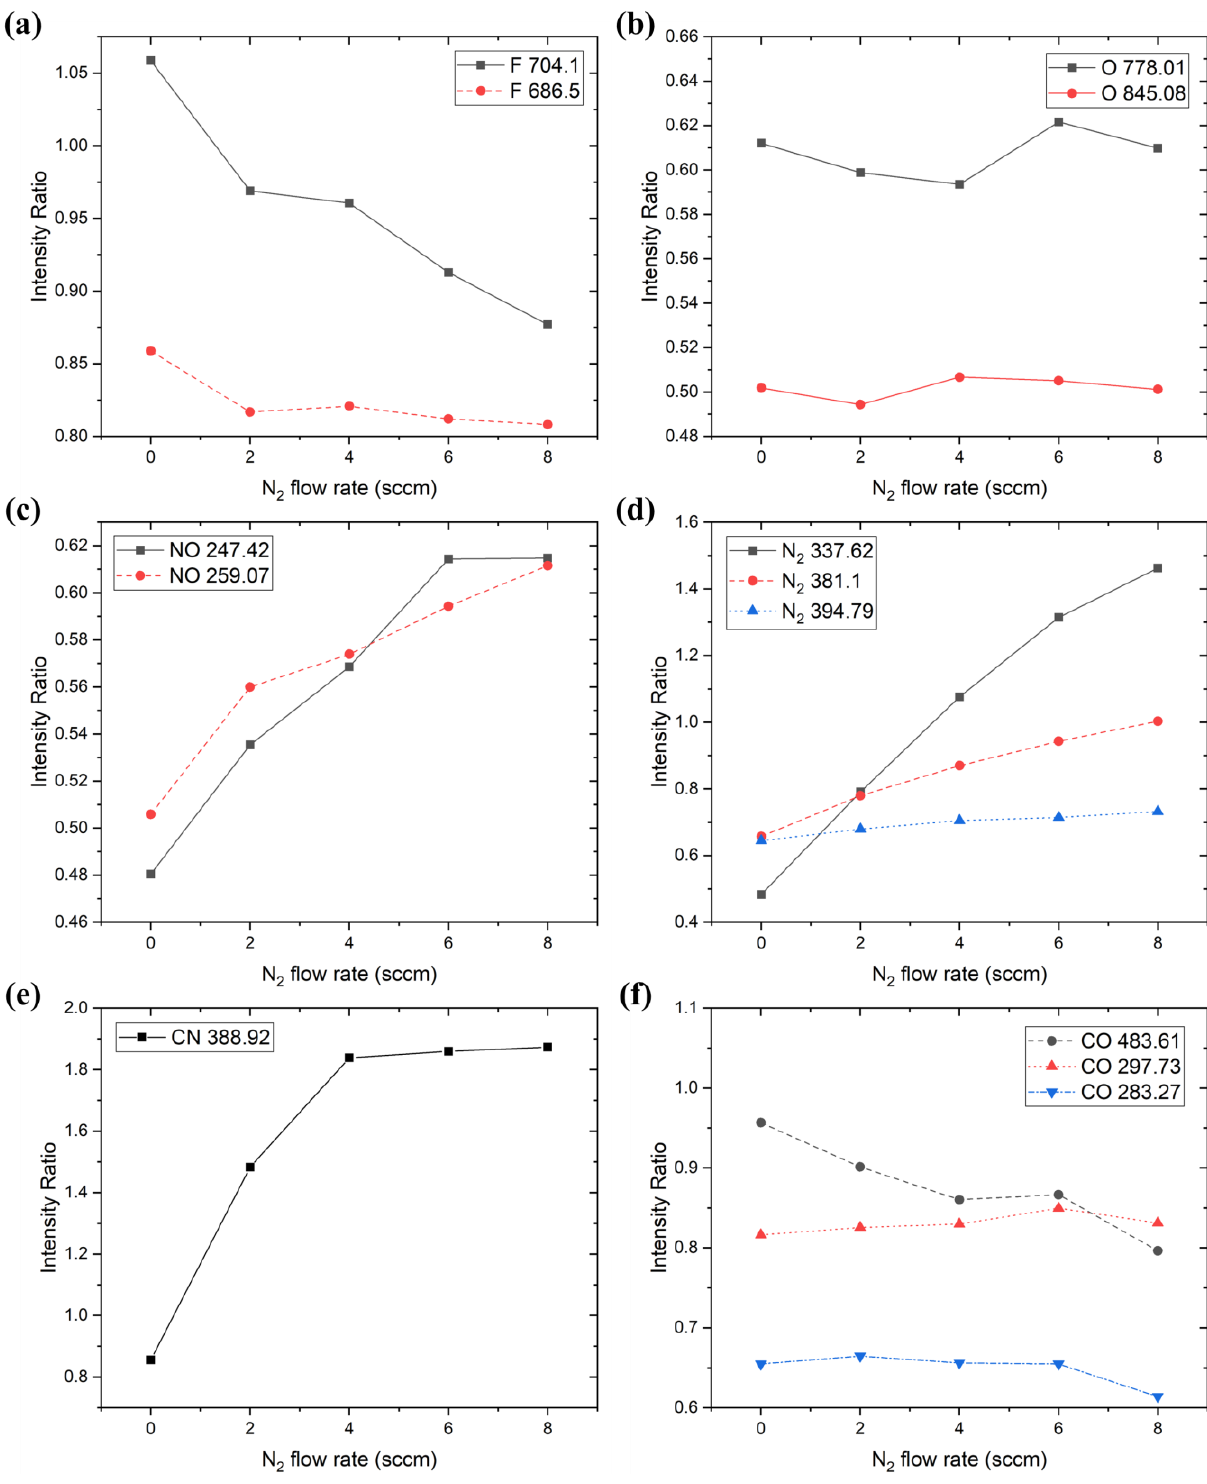
Figure 7. Actinometry results of ( a ) fluorine, ( b ) oxygen, ( c ) NO, ( d ) N 2 , ( e ) CN, and ( f ) CO. Si 3 N 4 etching was performed under the same experimental conditions as N 2 flow rate split cases discussed in Figure 7 to assess the effect of the change in the number of radicals as the flow rate of N 2 increased. The Si 3 N 4 etch rate was determined using a reflectometer to compare the thickness before and after etching. Figure 8 shows that the etch rate followed a similar pattern to the decreasing trend of F radicals owing to the